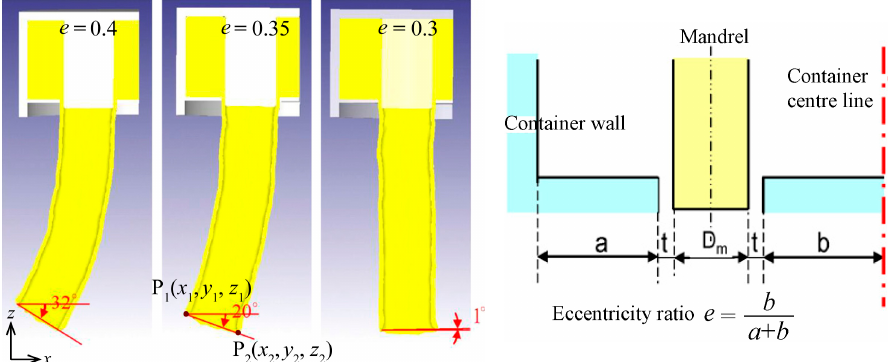
Figure 22. Effect of eccentricity ratio on profile curvature in two-hole extrusion. Reproduced with permission from ref. [89]. Copyright 2007 Elsevier B.V.